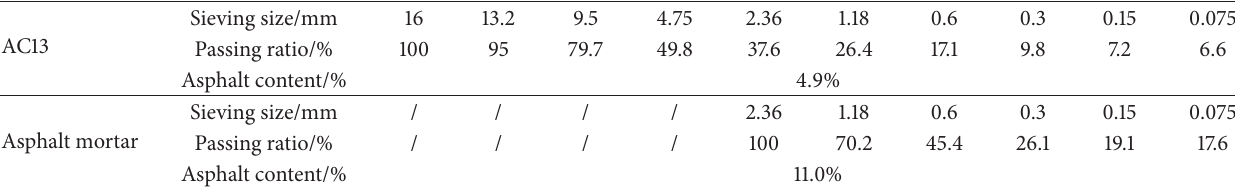
Table 1: Mix design of AC13 and asphalt